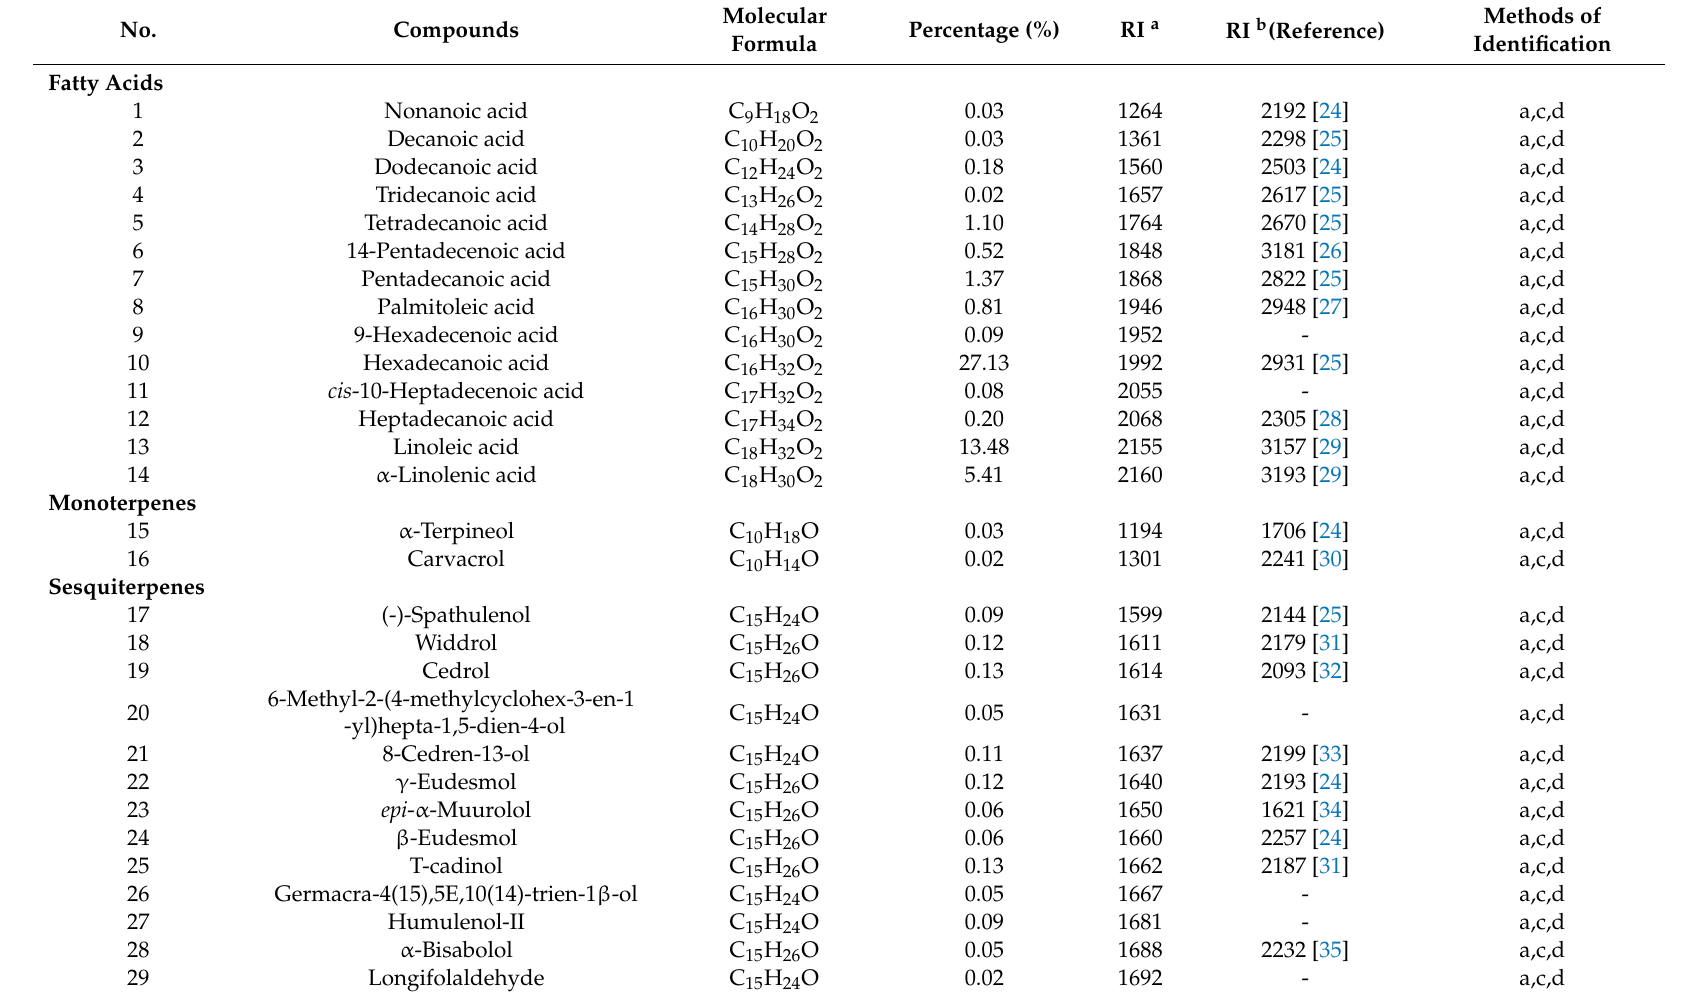
Table 1. Percent concentration (%) of chemical constituents of T. flousiana stem bark essential